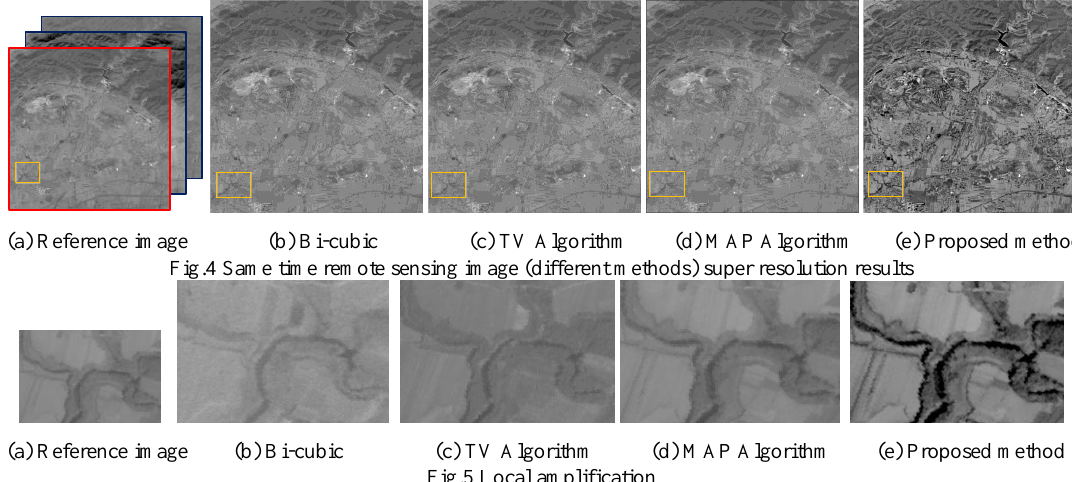
Fig.3 Synthetic image of different reconstruction methods